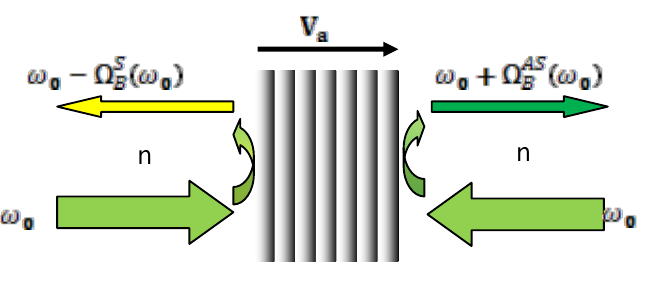
Figure 1. Schematic diagram for the Doppler